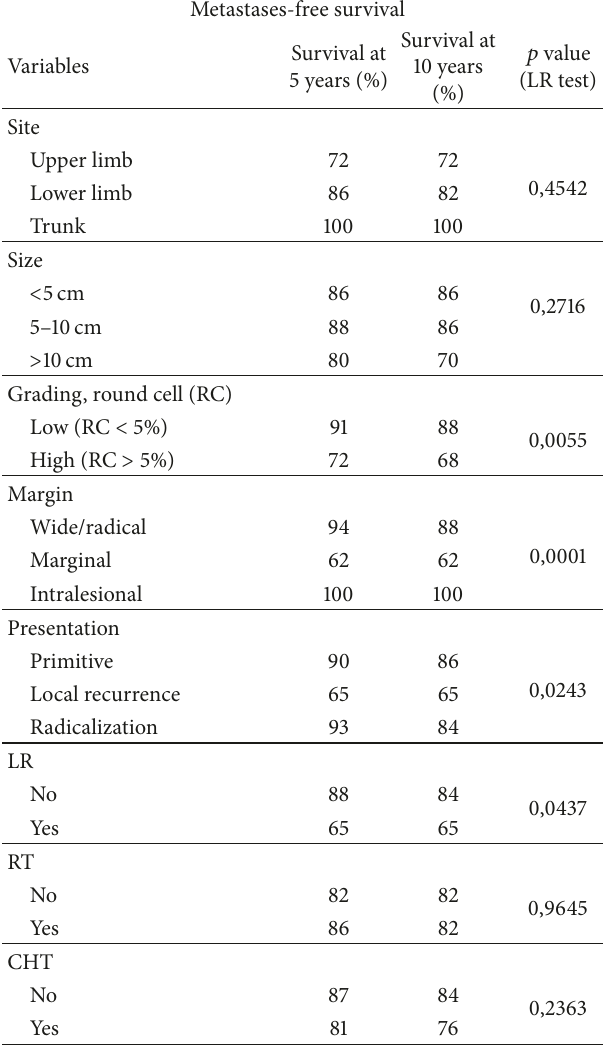
Table 5: Statistical analysis indicates margins ( 𝑝 = 0.0001 ), grading (0,0055), type of presentation ( 𝑝 = 0.0243 ), and local recurrence (0.0437) as risk factors on metastasis-free survival